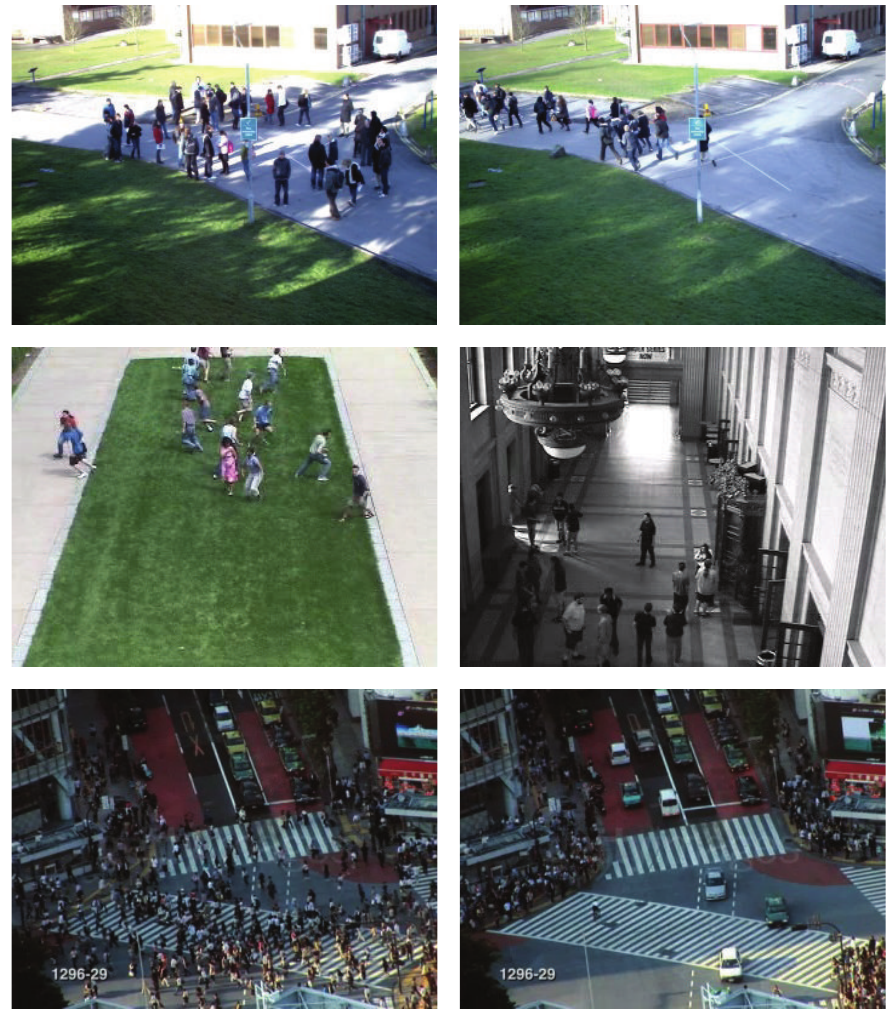
Figure 6: Sample frames from three